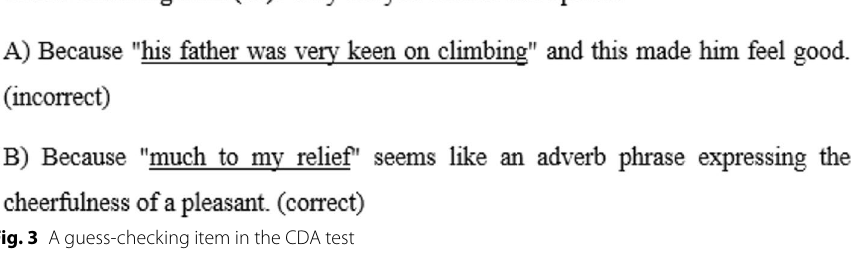
Fig. 3 A guess-checking item in the CDA test